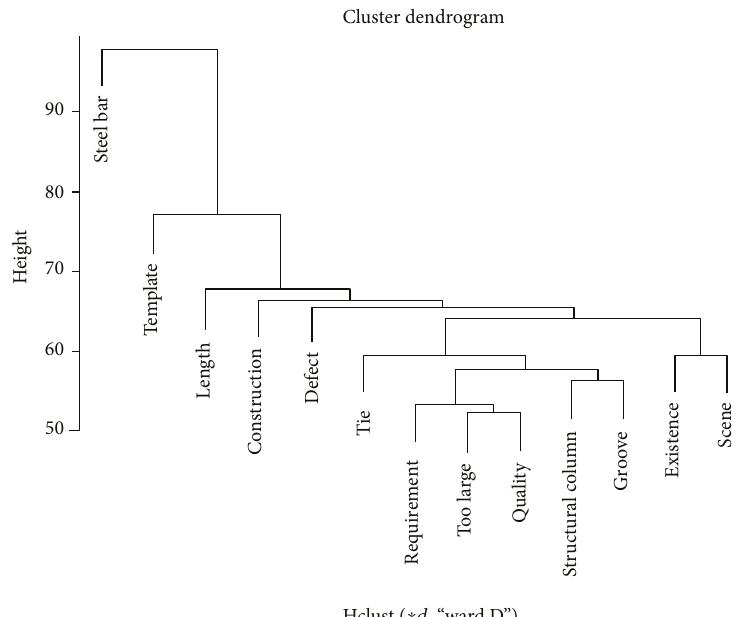
Figure 5: Text clustering